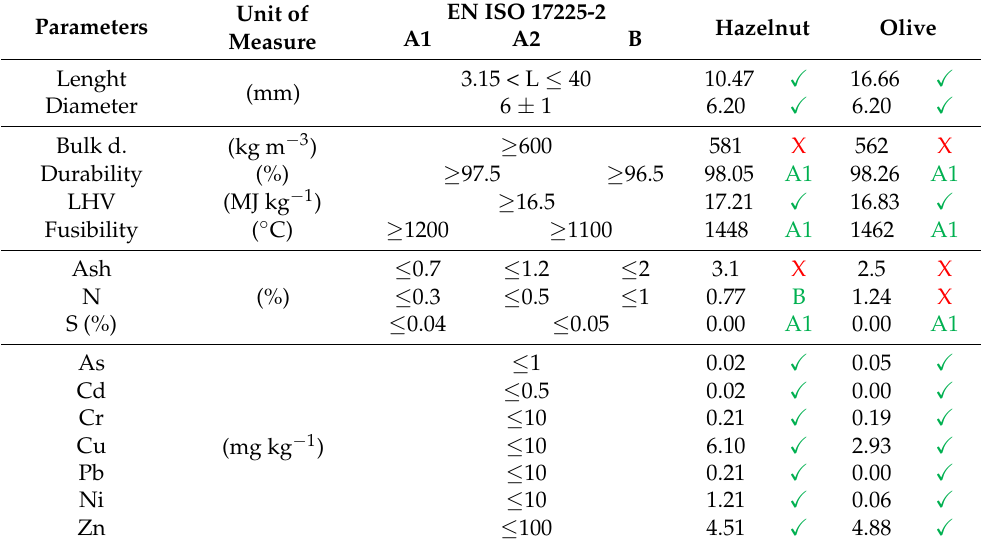
Table 8. Compliance of the quality parameters of the pellets produced according to the EN ISO 17225-2 classification: (cid:88) (complies with legislation), X (does not comply with legislation) A1-A2–B (quality classes).